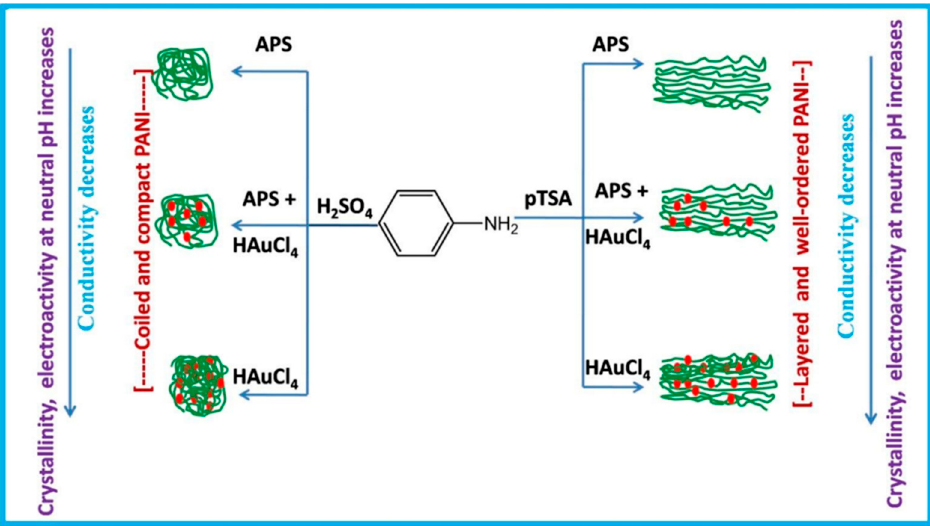
Figure 3. Schematic representation of different synthetic pathways for manufacturing the composite polyaniline-p-toluene sulphonic acids PANI-pTSA. Reproduced with permission from [98]. Copyright 2019 Elsevier B.V.